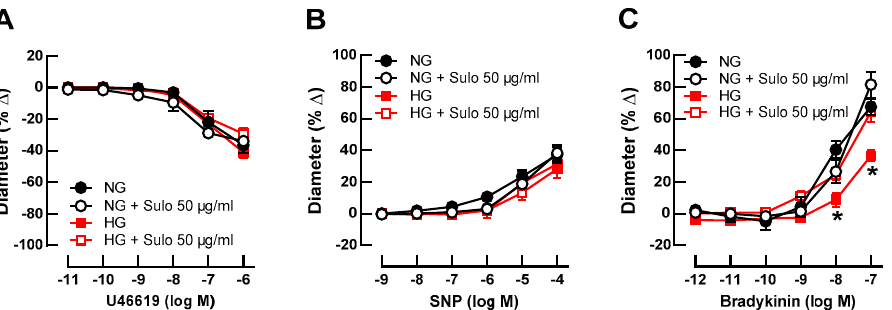
Figure 1. Concentration-dependent responses of porcine retinal arterioles after two hours of incu- bation with HG (highly concentrated glucose solution; 25 mM D-glucose), HG + Sulo 50 µg/mL (highly concentrated glucose solution + 50 µg/mL sulodexide), NG (normally concentrated glucose solution; 5.5 mM D-glucose), NG + Sulo 50 µg/mL (normally concentrated glucose solution + 50 µg/mL sulodexide) to the vasoconstrictor U46619 (A), the endothelium-independent vasodilator SNP (B), and to the endothelium-dependent vasodilator bradykinin (C). Data are presented as mean ± SE ( n = 8 per concentration and group; * p < 0.05, HG versus all other groups). To test whether sulodexide concentration-dependently prevented hyperglycemia-in- duced endothelial dysfunction, retinal arterioles were incubated with three different